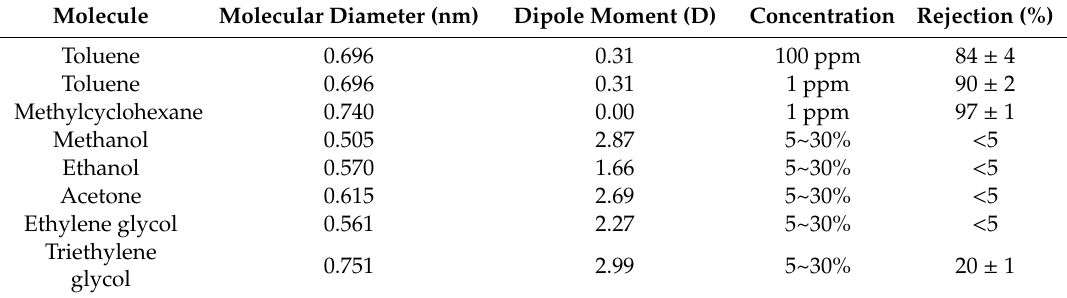
Table 3. Comparison of the rejection properties of GO membranes towards di ff erent molecules, all of them dissolved in water in concentrations below their solubility limit [60]. In all the cases, a pressure of 1 bar is applied on the feed side. The support layer chosen for all the measurements is